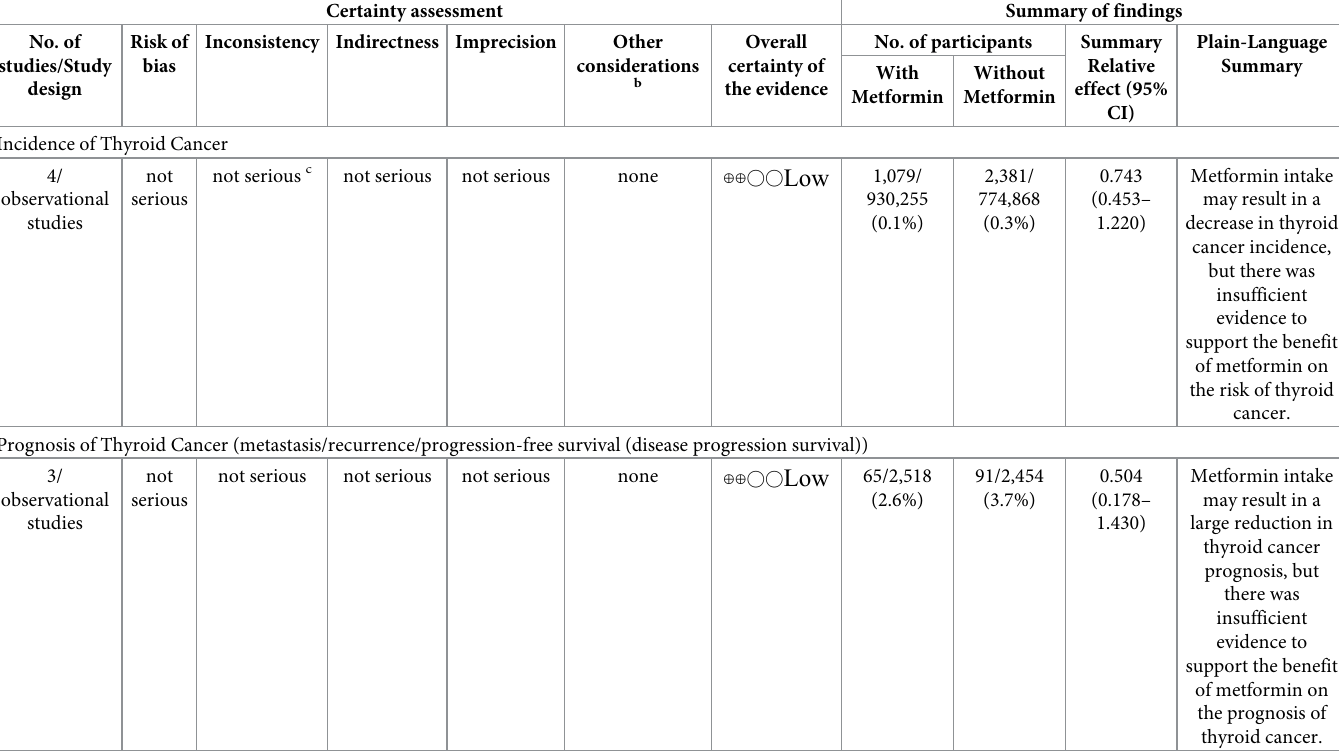
Table 2. GRADE evidence profile, a and summary of findings on metformin and thyroid cancer incidence and prognosis.